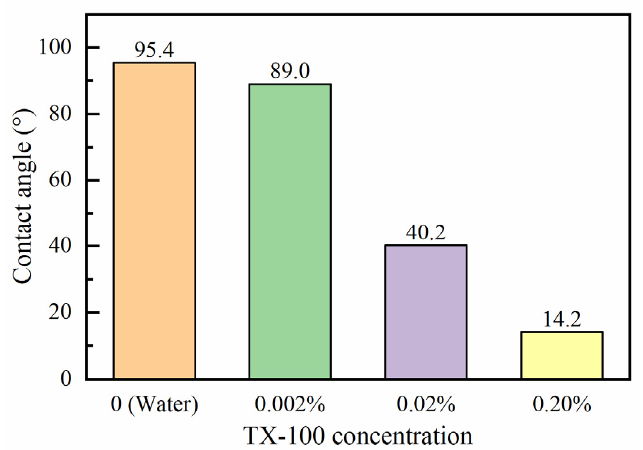
Figure 11. Contact angles between the mineral surface and different concentrations of TX-100 solutions after touching for 20 s.